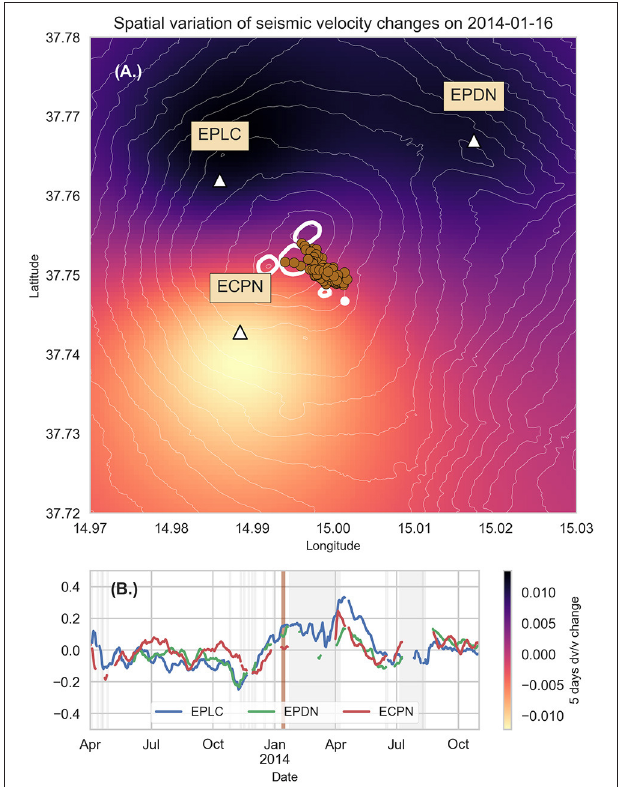
FIGURE 8 | (A) Interpolation map of the variation of seismic velocity over 5 days until 5 July 2014. The brown points are tremor centroid locations for the same time span. Unlike in Figure 7 the centroids are spread out with small cluster near the vent that opened on the flank of the NEC in July 2014. The seismic velocity is decreasing at stations EPLC and EPDN while it is increasing at station ECPN. (B) Seismic velocity variation in % at the considered